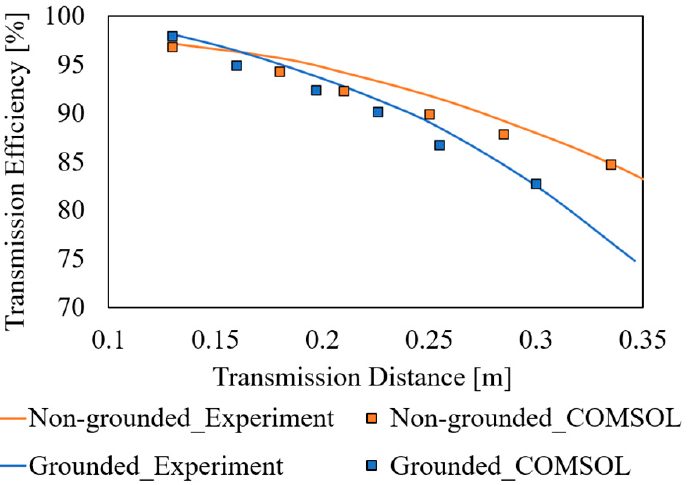
Figure 5. Experimental validation of transmission efficiency of MRC-WPTs’ two resonator types (10 MHz).